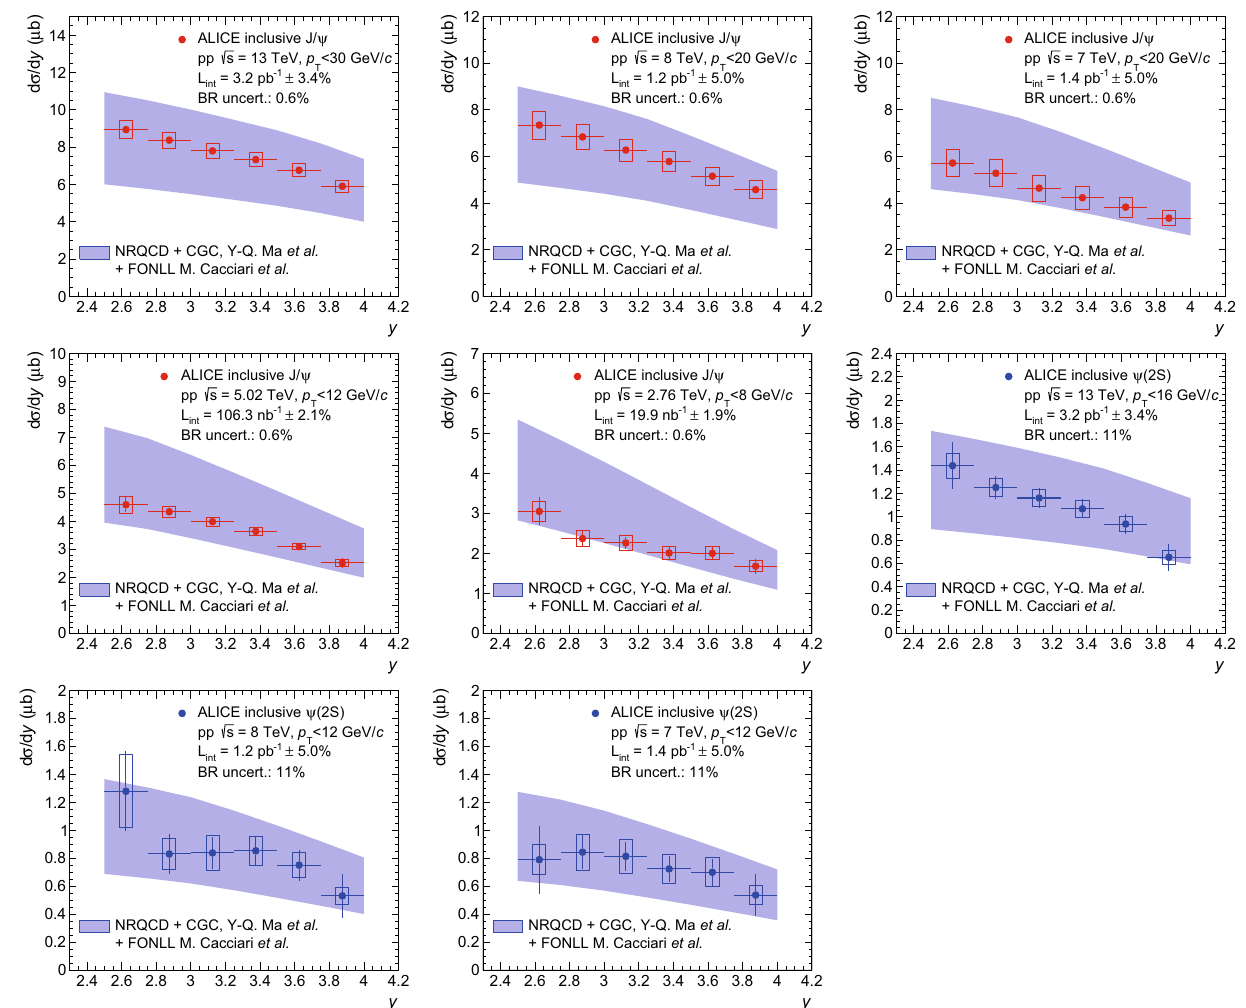
√ s = 13, 8 and 7, 5 . 02 and 2 . 76 TeV tion of y in pp collisions at ( red ), while the next three panels to inclusive ψ( 2S ) cross sections as a √ s = 13, 8 and 7 TeV ( blue function of y at